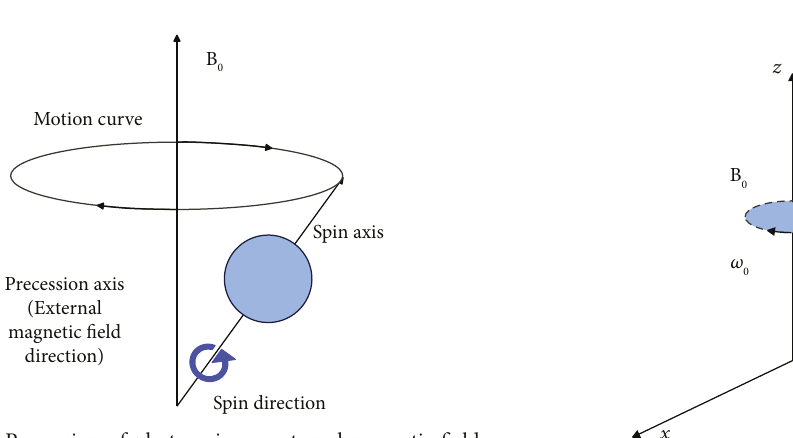
Figure 4: Nutation of